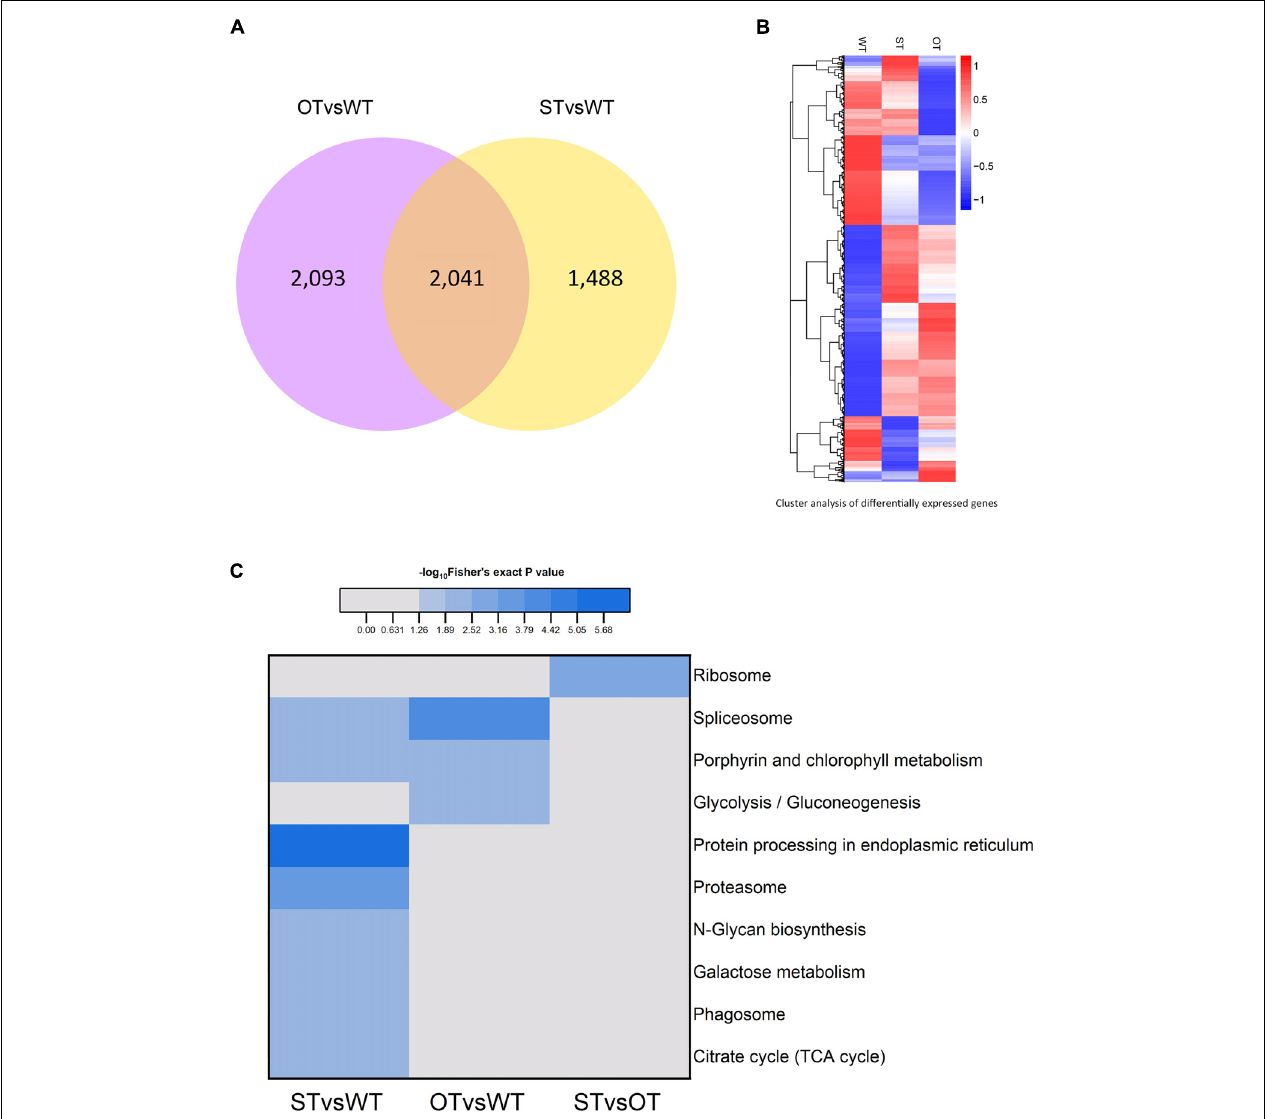
FIGURE 2 | Analysis of the transcriptome of ST and OT seeds relative to that of WT seeds (three biological replicates per genotype). (A) Venn diagram. (B) Cluster analysis. In B , the greater the intensity of the red color, the higher the gene expression; and the greater the intensity of the blue color, the lower the gene expression. (C) Heat map showing the results of KEGG pathway enrichment analysis of genes differentially expressed between WT, MIM164c (ST), and OE164c (OT) seeds.